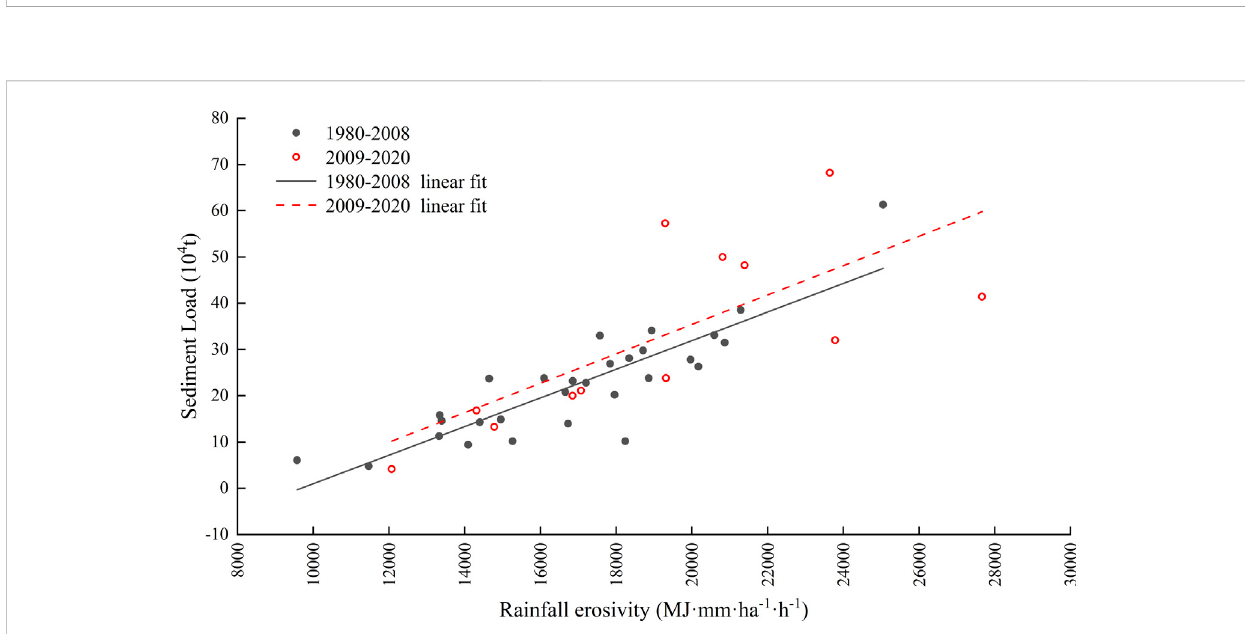
Linear fi tting of sediment load and rainfall erosivity at different periods in Nandu River Basin.